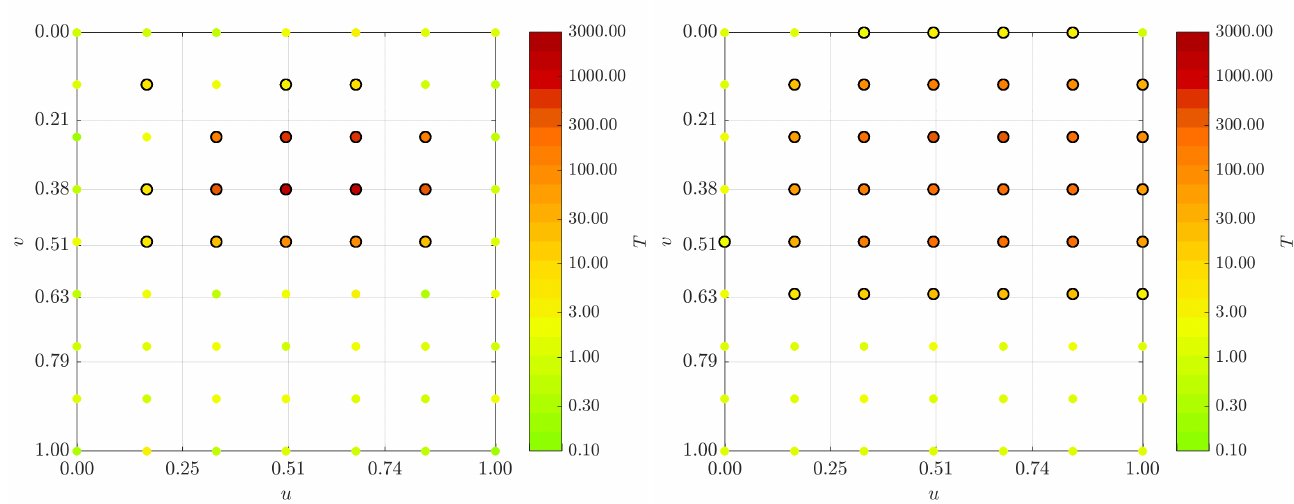
Figure 10. Test values T of the localisation procedure for data set V15. For the circled points, the null hypothesis has to be rejected and, hence, these points are assumed to lie in the distorted region. Left: a = 0, right: a =